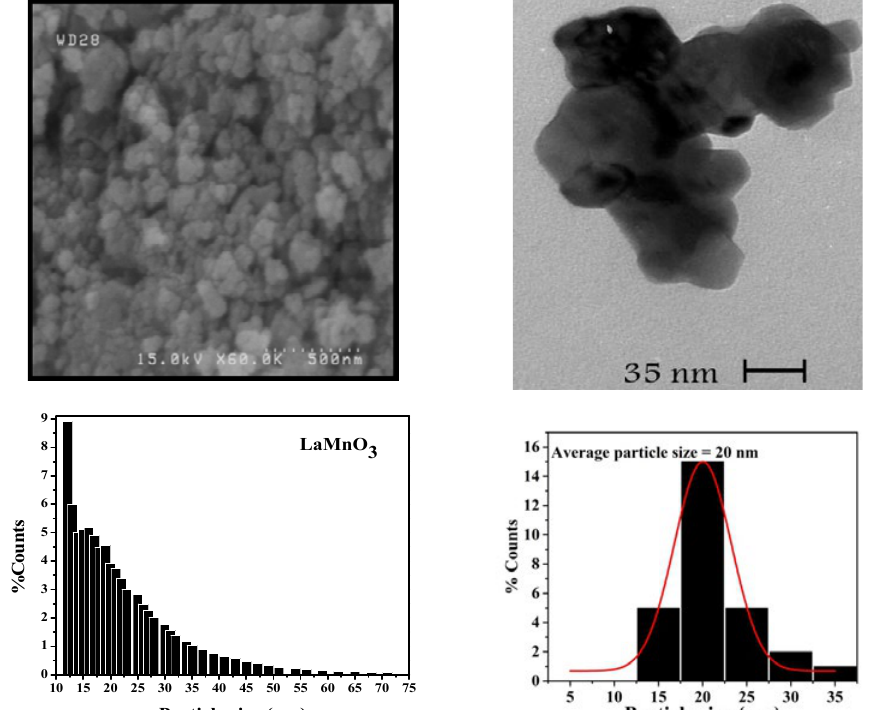
Fig. 3. SEM and TEM micrographs, PSD and size distribution histograms of the prepared crystalline sample.